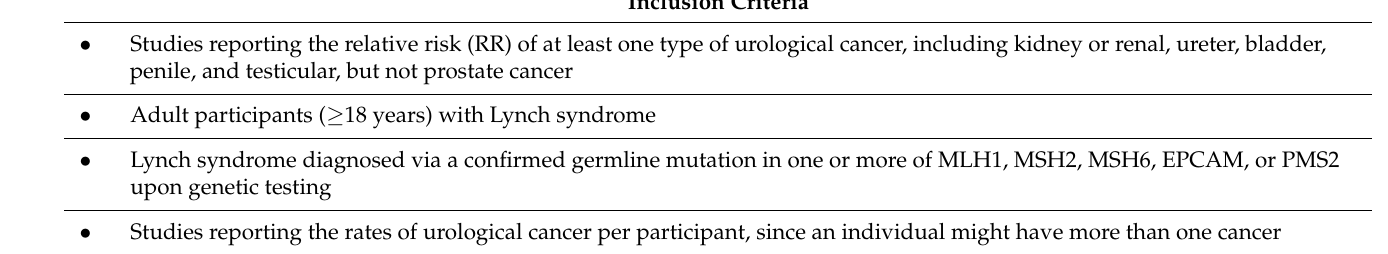
Table 1. Study eligibility